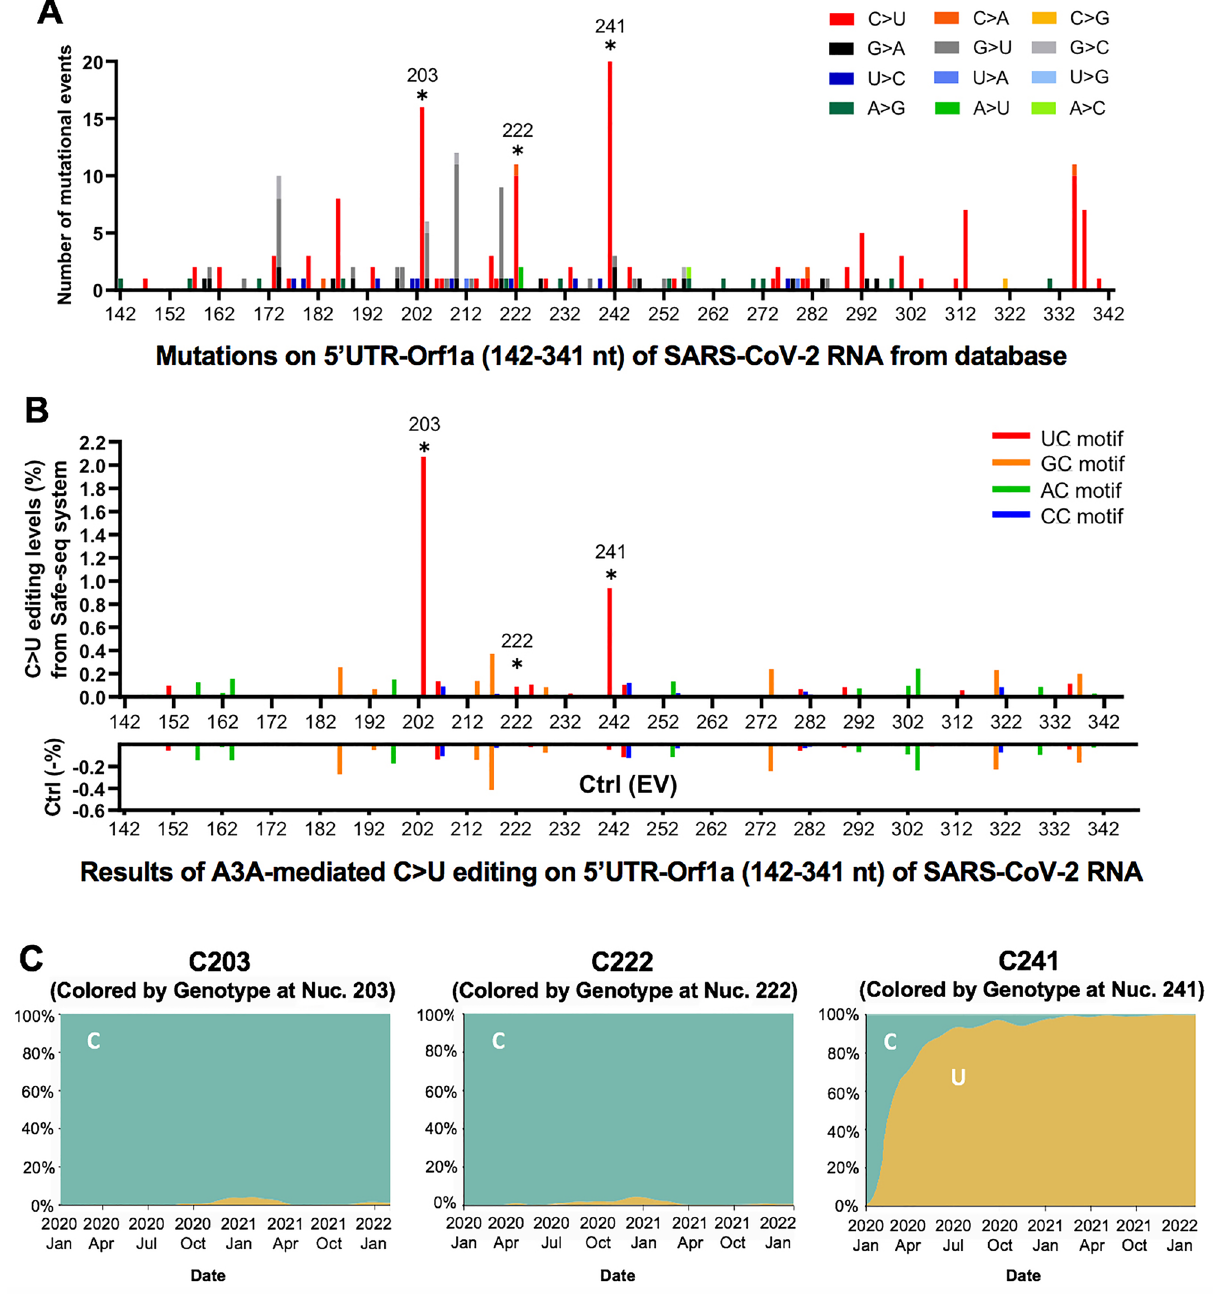
Figure 4. The potential effect of APOBEC-mediated editing on SARS-CoV-2 mutations and fitness. ( A ) The number of mutational events (all single nucleotide variants) on SARS-CoV-2 RNA segment 5’UTR-Orf1a (segment 1 in Fig. 1A) from the SARS-CoV-2 genome sequence data (the Nextstrain datasets from Dec. 2019 to Jan. 22nd, 2022 downloaded from the GISAID database, https:// www. gisaid. org/ hcov19- varia nts/ and https:// nexts train. org/ ncov/ global). The C203, C222, and C241 represent many of the C-to-U mutational events (asterisks) with the A3A-editing UC motif in the SARS-CoV-2 variants. ( B ) The A3A-mediated C-to-U editing rate on UC motif in the same 5 ′ UTR-Orf1a region obtained from our cell-based editing system and the SSS analysis. The Ctrl (EV) editing levels (or background error rates) of the corresponding region are presented as negative values (%). The C203, C222, and C241 (asterisks) all showed significant editing by A3A. ( C ) The C-to-U mutation prevalence over time at C203, C222, and C241. The sequencing frequency is represented by C in blue and U in yellow (referred to the Nextstrain datasets: https:// nexts train. org/ ncov/ global). This analysis showed that SARS-CoV-2 started to acquire the C-to-U mutation at C241 in January 2020. By July 2020, 90% of the circulating viral variants carry this mutation at C241. By March 2021, almost all circulating viral variants have this mutation, suggesting the C241 to U mutation in the 5’UTR is beneficial to the viral fitness (see Supplementary Fig.